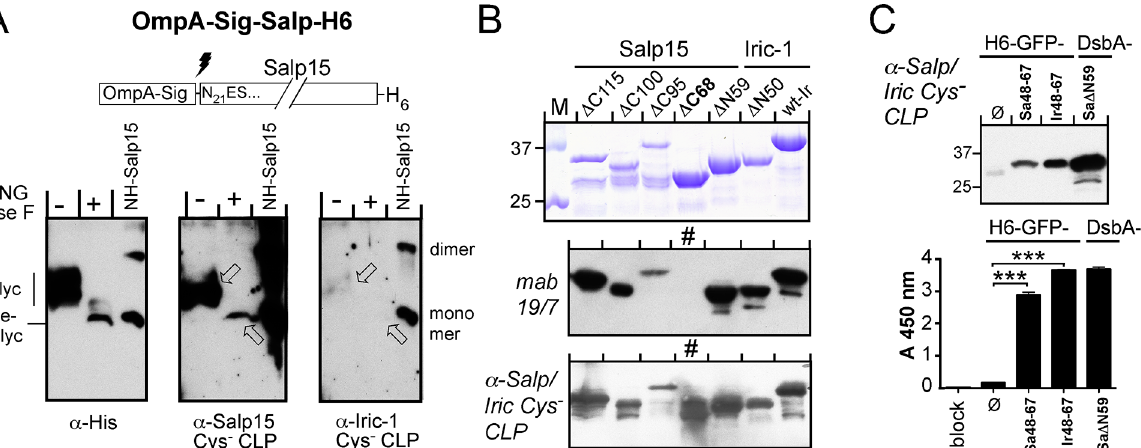
Fig 8. Breadth of antibody reservoirs evoked by CLPs presenting Cys-free Salp15 and Iric-1. (A) Recognition of secreted glycosylated Salp15. C terminally His6 tagged Salp15 secreted from HEK 293 cells transfected with an OmpA signal peptide bearing construct (OmpA-Sig-SalpH6) was affinity- captured using Ni-NTA beads. One part was analyzed by immunoblotting without further treatment (-), the other after incubation with PNGase F to remove N- linked glycans (+); the positions of glycosylated (glyc) and deglycosylated (deglyc) Salp15 are indicated. 50 ng of solubilized recombinant H6-Salp15 served as reference. Three parallel blots were individually probed with an anti-His-tag mab, and IS against Cys-free Salp15 or Cys-free Iric-1 CLPs. The anti-Iric- CLP IS showed almost no reaction with secreted Salp15 and reacted at least ten-fold less efficiently with the reference protein. The upper bands in the reference lanes recognized by this IS and also the anti-His-tag mab represent S-S-linked dimers present in the solubilized H6-Salp15 preparation. (B) Antibodies in IS induced by Cys-free tick protein presenting CLPs recognize epitopes all along the primary sequence of wt Salp15. E . coli derived DsbA fusions with truncated Salp15 and Iric-1 [10] served as test antigens. Top : Coomassie Blue stained SDS-PAGE. Middle : A second SDS-PAGE gel was loaded with one fifth the amount of each protein, blotted, and probed with mab 19/7.4 which recognizes an epitope between residues 83 and 92 of Salp15 that is conserved in Iric-1. Variant Salp15 Δ C68 lacks this epitope and is not recognized (lane marked with #). Bottom : Antigens were blotted as in the middle panel but probed with pooled IS ( α -Salp/Iric Cys - CLP) from the immunizations with CLPs presenting Cys-free Salp15 and Iric-1. The strong reaction with the DC68 protein demonstrates the presence of epitopes upstream of Salp15 aa 68. (C) Recognition of the OspC interaction sites on Salp15 and Iric-1. Recombinant His-tagged GFP (H6-GFP) bearing no extra sequence ( ø ) or the OspC binding regions (aa 48 – 67) of Salp15 or Iric-1 [10] was probed with the α -Salp/Iric Cys - CLP IS; DsbA-Sa Δ N59 protein served as positive control. Top : Immunoblot, developed using a secondary anti-mouse PO conjugate and chemiluminescent substrate. Bottom : ELISA, using the indicated proteins as immobilized test antigens. Lane "block", blocking solution only. Note the significantly stronger reaction of the IS with GFP bearing the OspC interacting Salp15 and Iric-1 regions compared to GFP